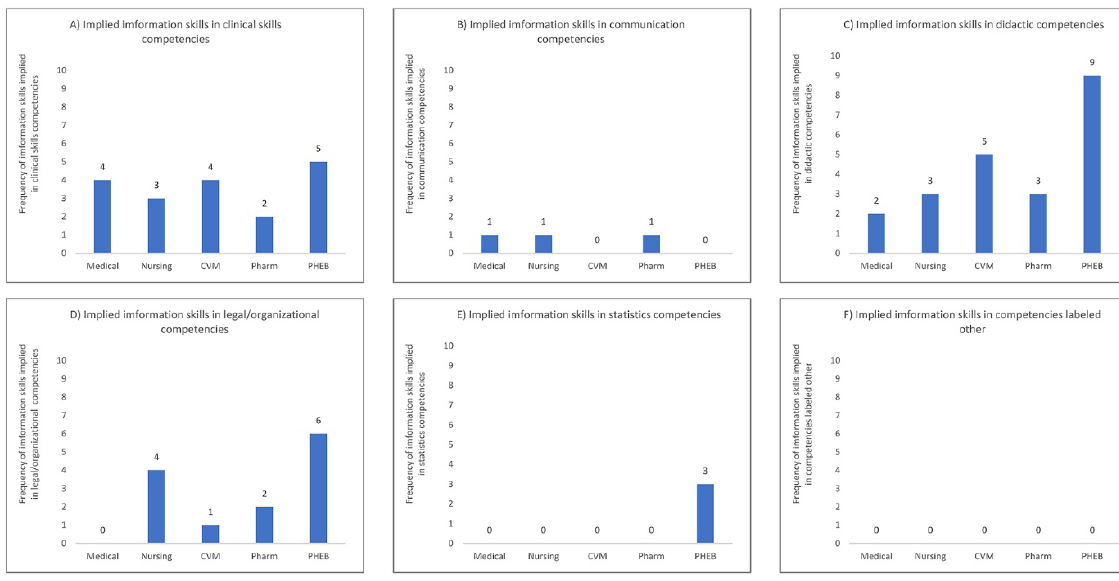
Figure 1 Co-occurrences of implied competencies occurring in the 6 coding categories other than information skills and behaviors for the professional program curricular